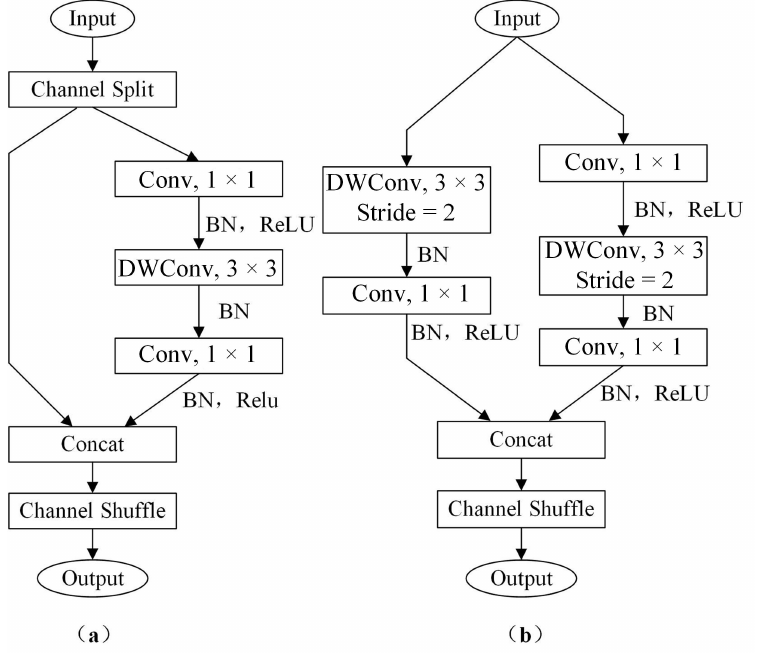
Figure 1. Two types of bottleneck structures for ShuffleNet v2. ( a ): The basic unit of ShuffleNet v2 in the case of stride of 1. ( b ): The basic unit of ShuffleNet v2 in the case of stride of